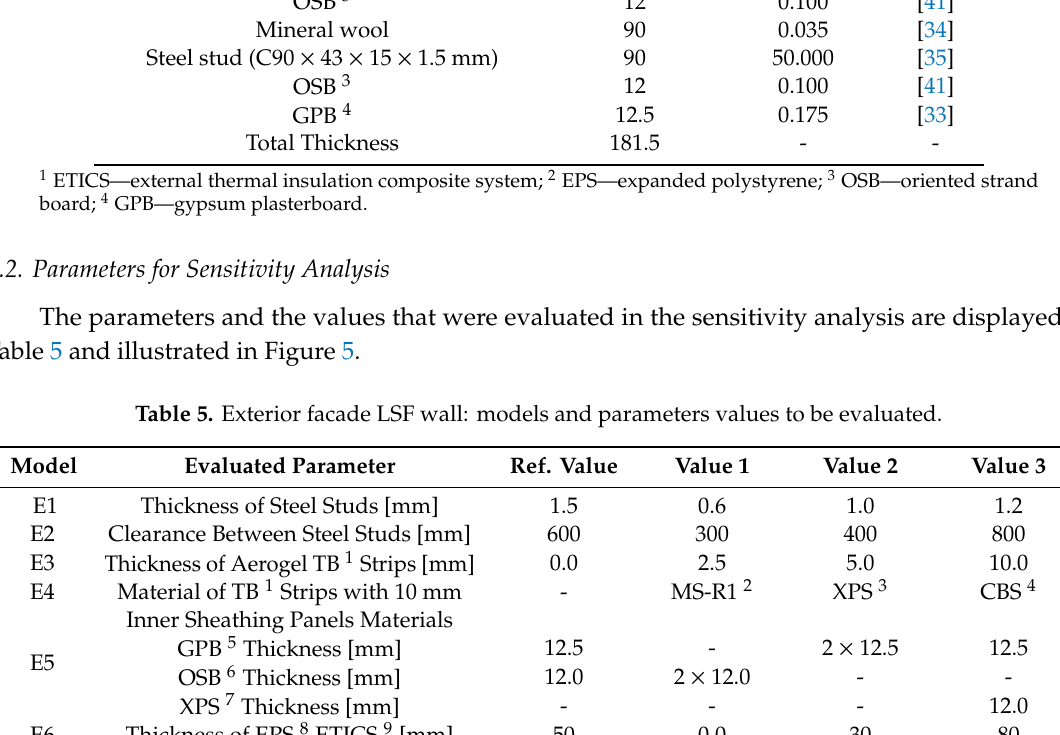
Table 4. Materials, thicknesses ( d ) and thermal conductivities ( λ ) of the reference exterior facade wall. Material (From Outer to Innermost Layer) d [mm] λ [W / (m.K)] Ref. ETICS 1 finish 0.450